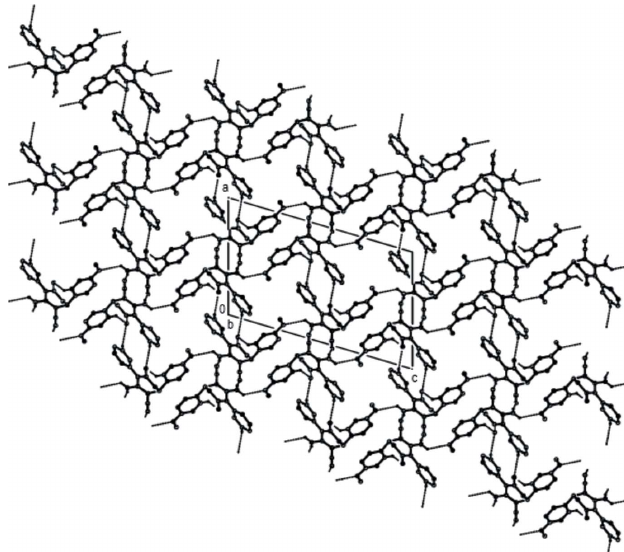
Figure 3 The crystal packing of the title compound, viewed along the b axis, showing the N—H (cid:2)(cid:2)(cid:2) N, N—H (cid:2)(cid:2)(cid:2) O and C—H (cid:2)(cid:2)(cid:2) O hydrogen bonds as dashed lines.